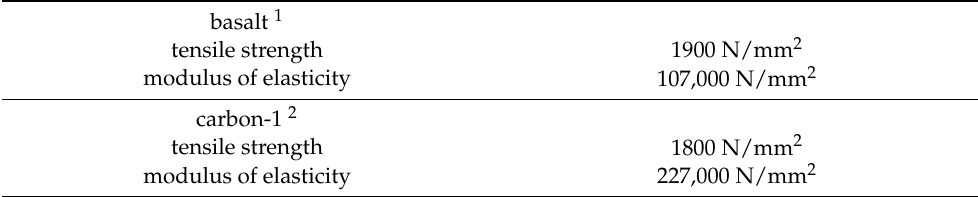
Figure 1. Fabrics used in the test: ( a ) basalt, ( b ) carbon-1; ( c ) carbon-2; ( d ) AR glass; ( e ) PBO. Table 2. Mechanical properties of fabrics used in the tests.